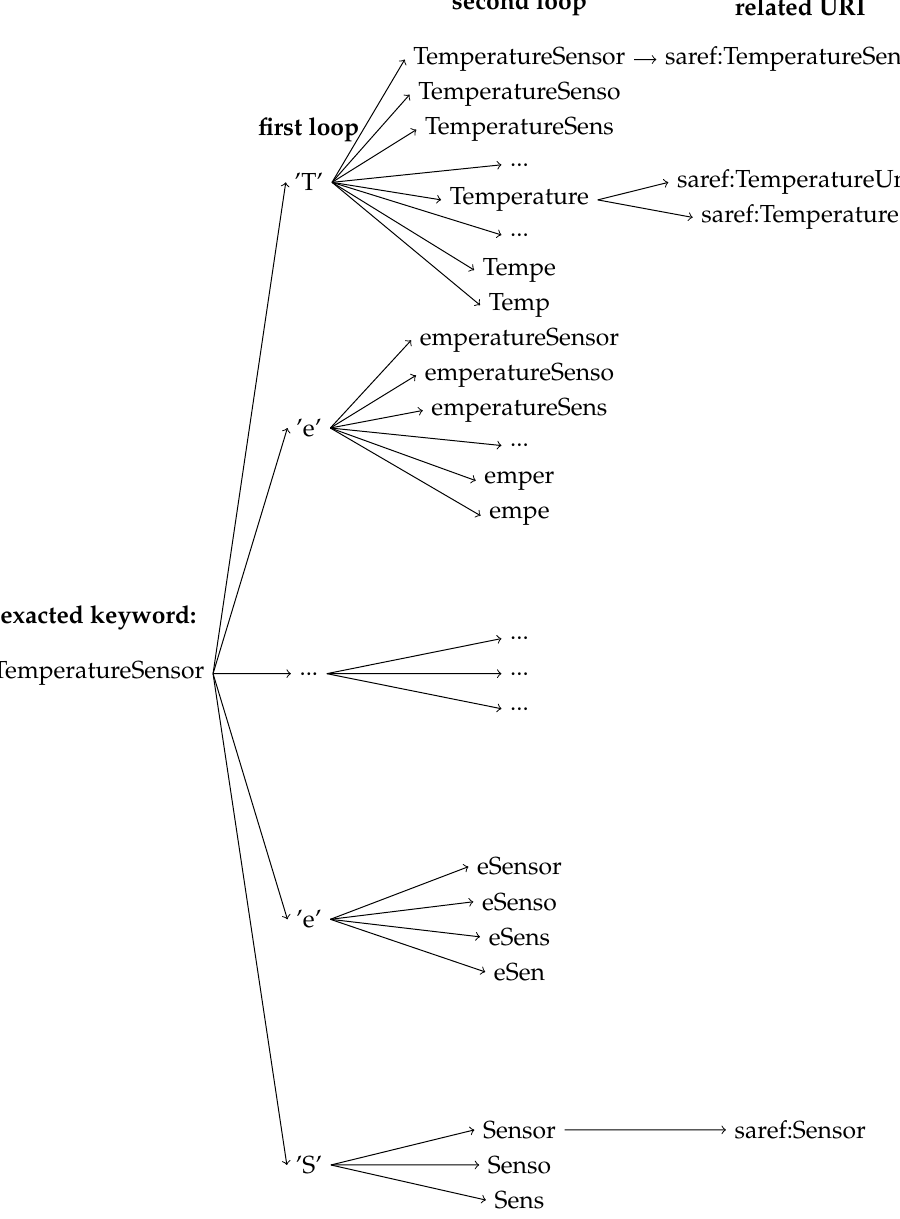
Figure 7. Extracting morphemes of a keyword